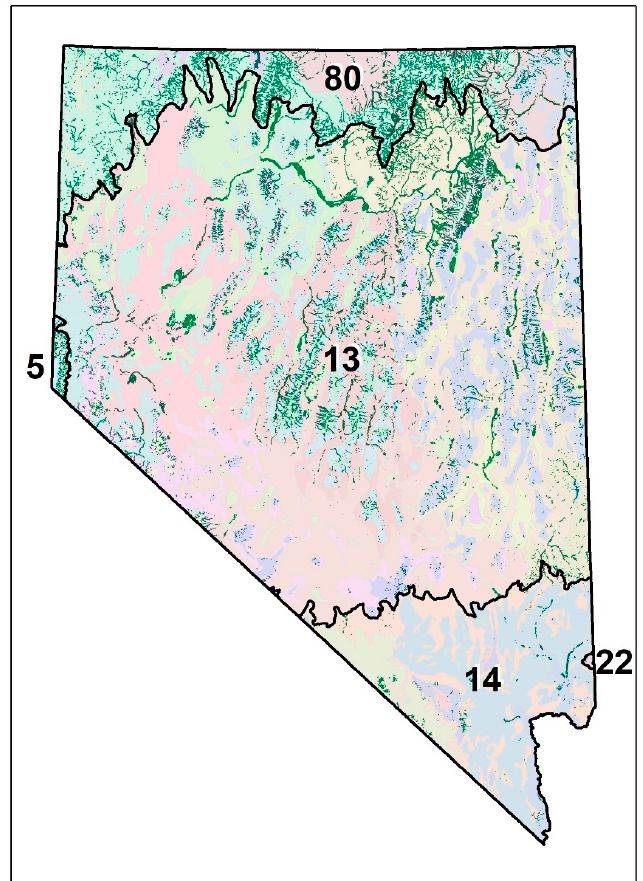
Figure 1. Study area showing riparian areas from the Map of Riparian Vegetation of Nevada (MRVN) in dark green and 45 Level 4 (colors) ecoregions. Level 4 ecoregions are nested within Level 3 ecoregions (black lines) including the Northern (80), Central (13) and Mojave (14) Basin and Range, the Sierra Nevada (5), and the Arizona/New Mexico Plateau (22).